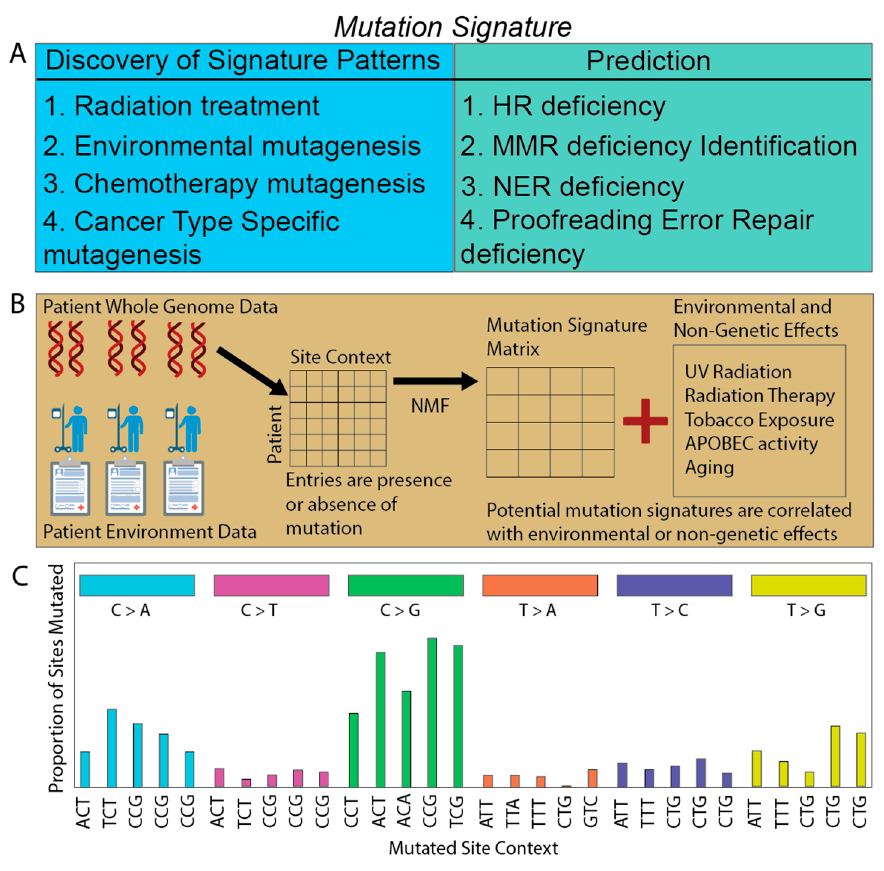
Figure 1. Mutation-signatures overview. ( A ) Mutation signatures have been used for discovery of genomic patterns reflecting the effects stressors have on the cancer genome and for phenotype prediction. ( B ) Simplified illustration of the construction of mutation signatures. Whole-genome-sequencing (WGS) data are collected and combined into a matrix. The matrix is decomposed using non-negative matrix factorization (NMF) or a similar method, and the resulting mutation-signature matrix is then correlated with environmental, patient-specific, or cancer-specific effects. ( C ) Simplified example of a potential mutation signature. The x-axis is site-specific nucleotide contexts. The colored boxes indicate groupings of the same nucleotide transition. The y-axis is the proportion of those context-specific sites that are mutated according to the specified transition. Only 30 of the 96 total potential sites are shown here for clarity.